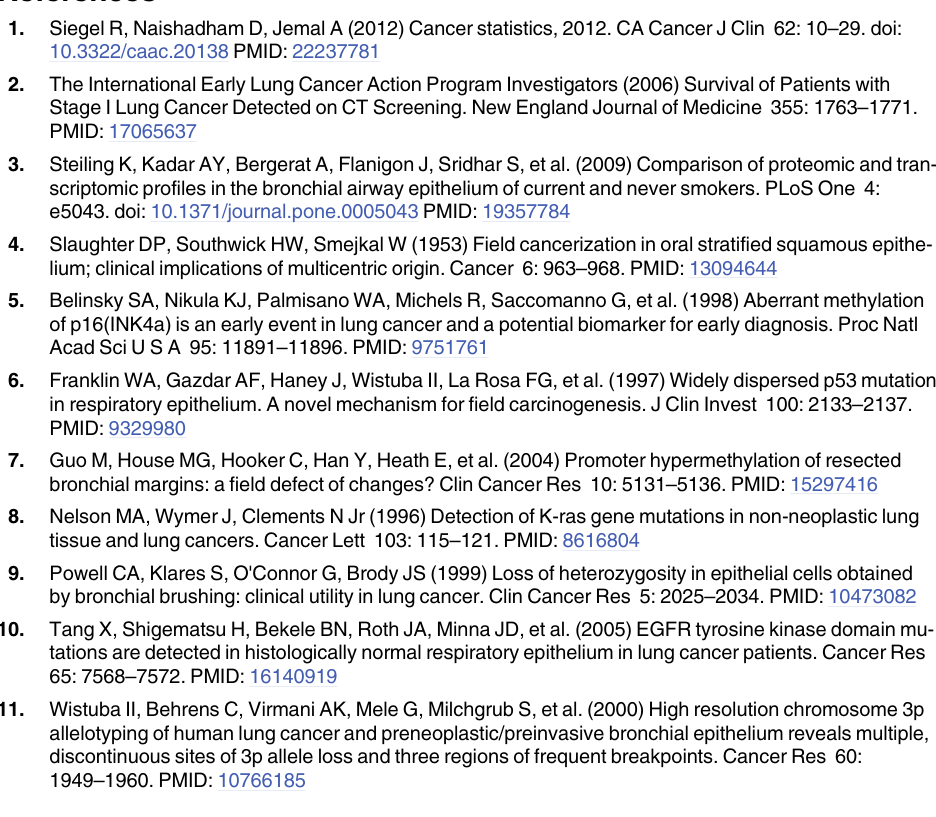
S6 Table. Integrative negatively correlated mRNA-miRNA pairings base on TargetScan. S7 Table. Transcriptomic profile comparison to Kadara et al. S8 Table. Gene expressions comparison between peripheral airway epithelial cells and large airway epithelial